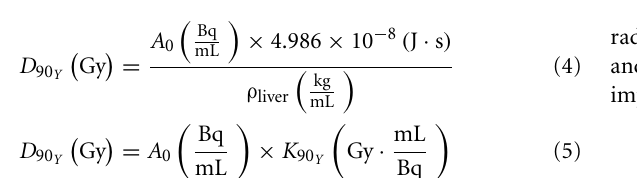
FIGURE 2 |Transaxial profile of a 90 Y line source in water compared to a Gaussian profile with the same FWHM (3.1mm)